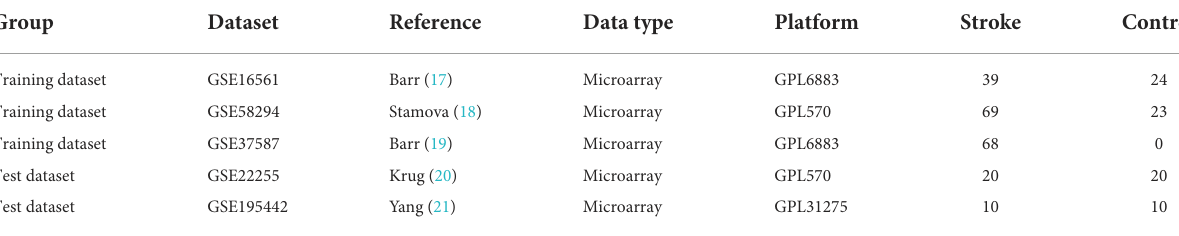
TABLE 1 Ischemic stroke datasets from the GEO